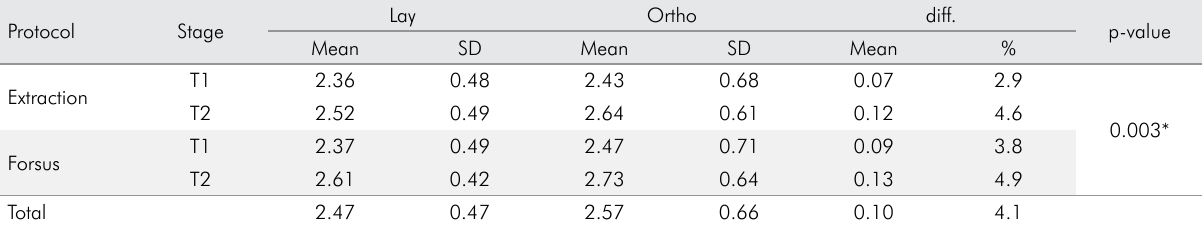
Table 4. Three-way mixed-model analysis of variance for comparison of scores assigned according to the category of evaluators.